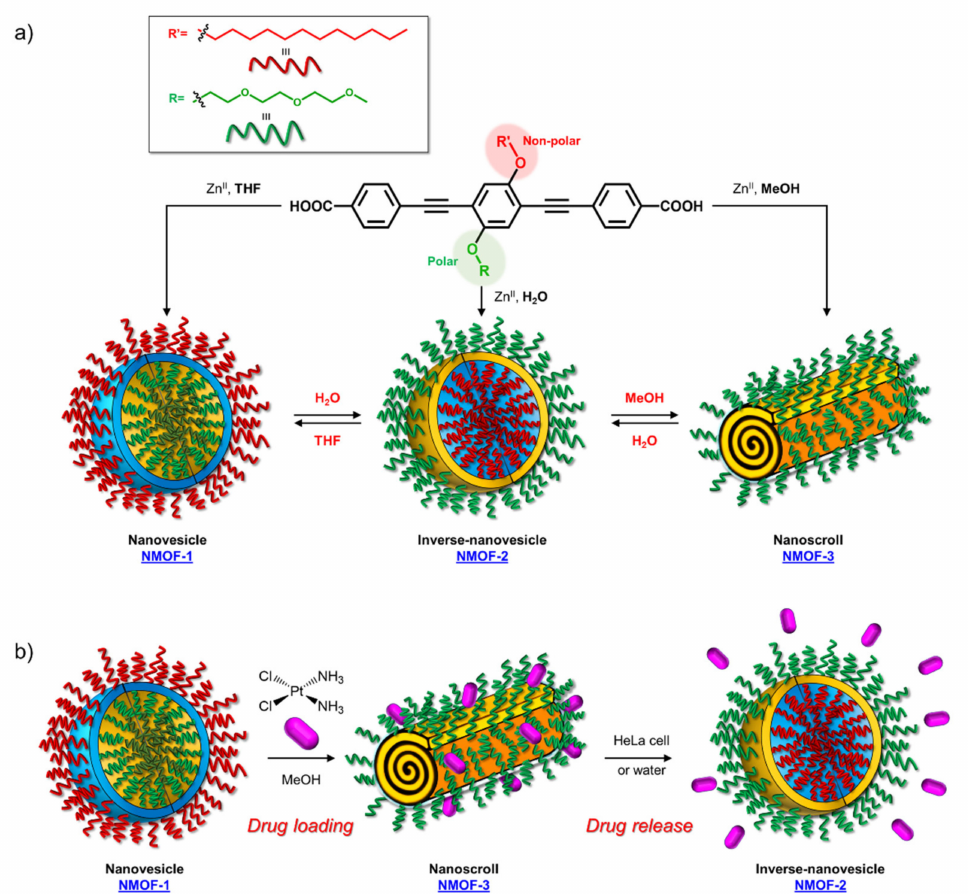
Figure 3. Schematic representation of ( a ) synthesis and morphology of NMOFs and ( b ) drug loading and release of